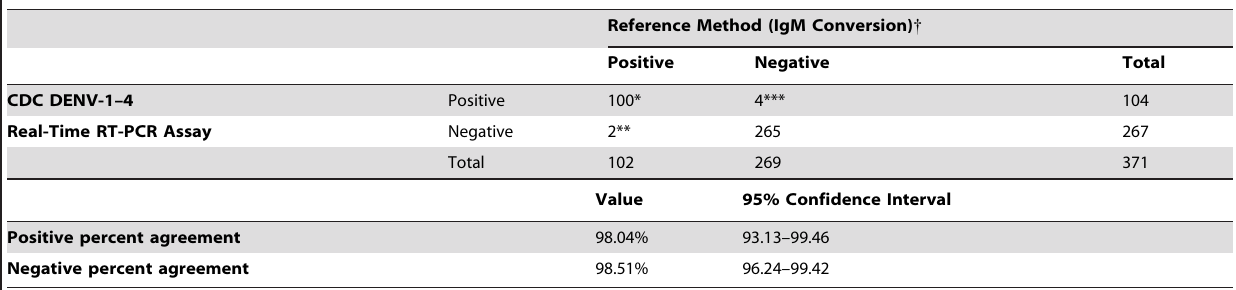
Table 8. Agreement between CDC DENV-1–4 Real Time RT-PCR and seroconversion in samples from suspected dengue